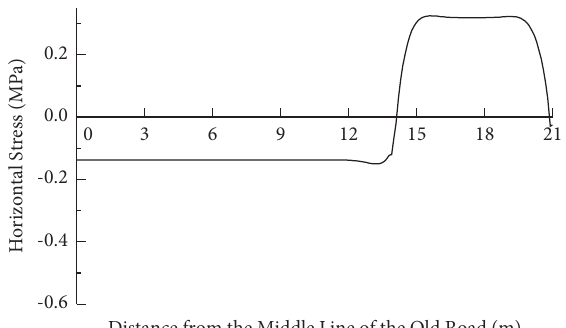
Figure 17: Horizontal stress at the bottom of the subbase.